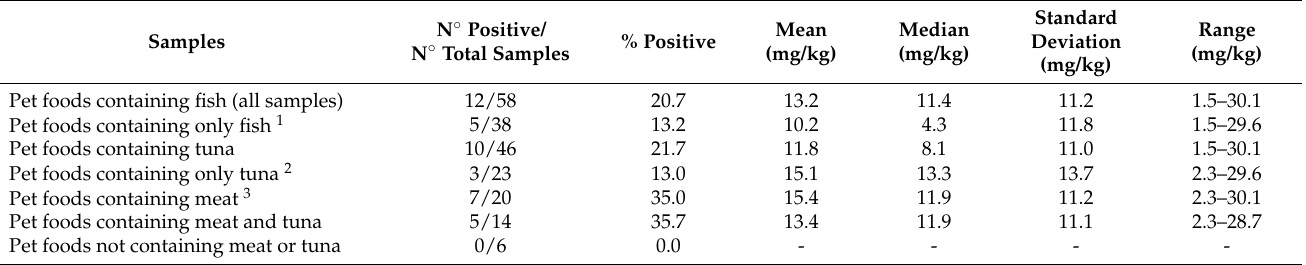
Table 5. Occurrence of histamine in pet-food samples grouped on the basis of the ingredients of animal